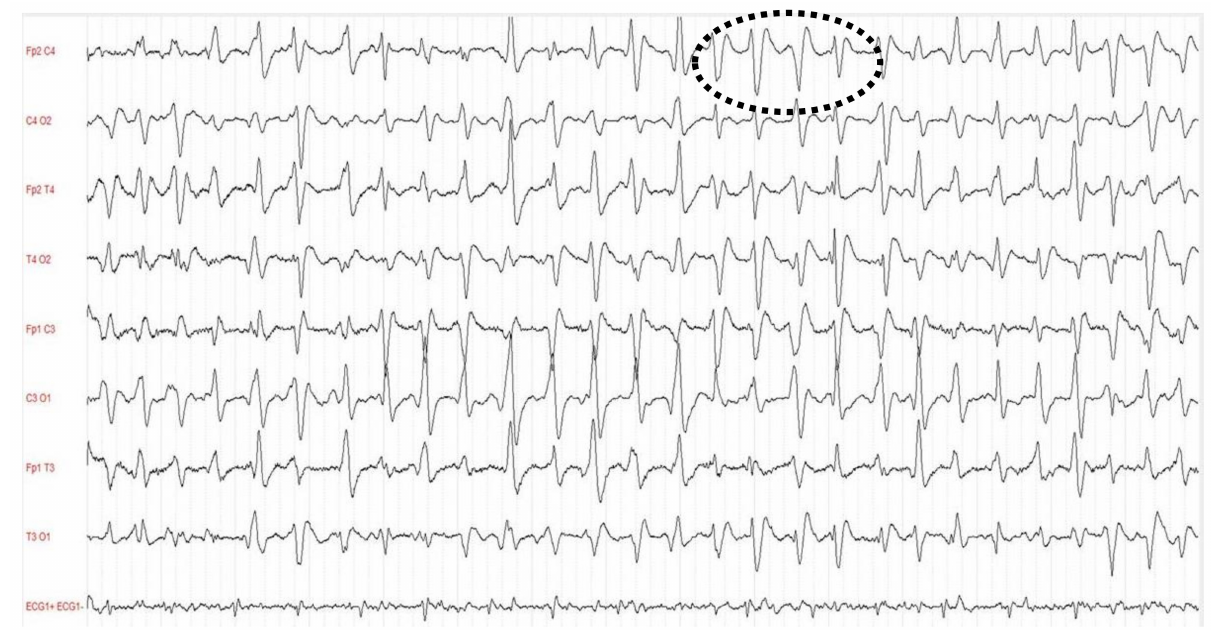
Figure 1. Triphasic wave in an electroencephalography (EEG) of patient with sepsis-associated encephalopathy